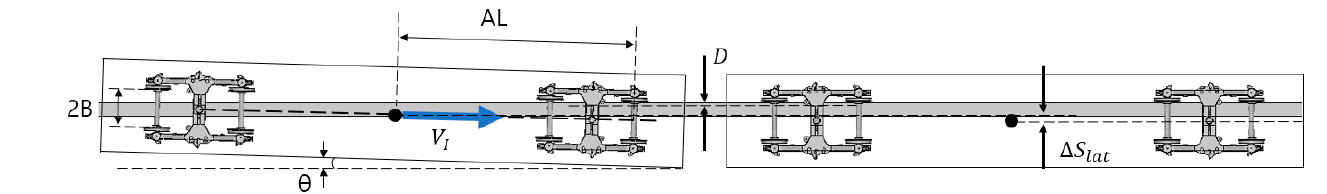
Figure 6. Olson model applied for the DCP Type 1. 4. Estimation of Impact Angle If a train derails from the rail and simply moves in a straight direction from the de- railment location shown in Figure 7, it will move a distance of L and collide with the DCP at impact location 1. At this time, the impact angle between the DCP and the vehicle can